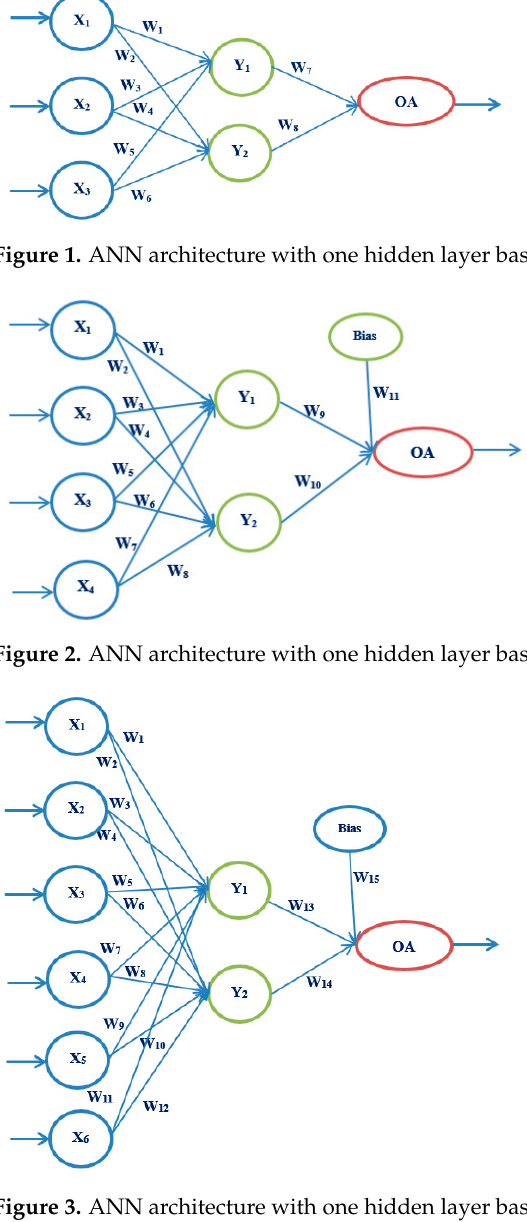
Figure 3. ANN architecture with one hidden layer based on OA16 (ANN-OA16).